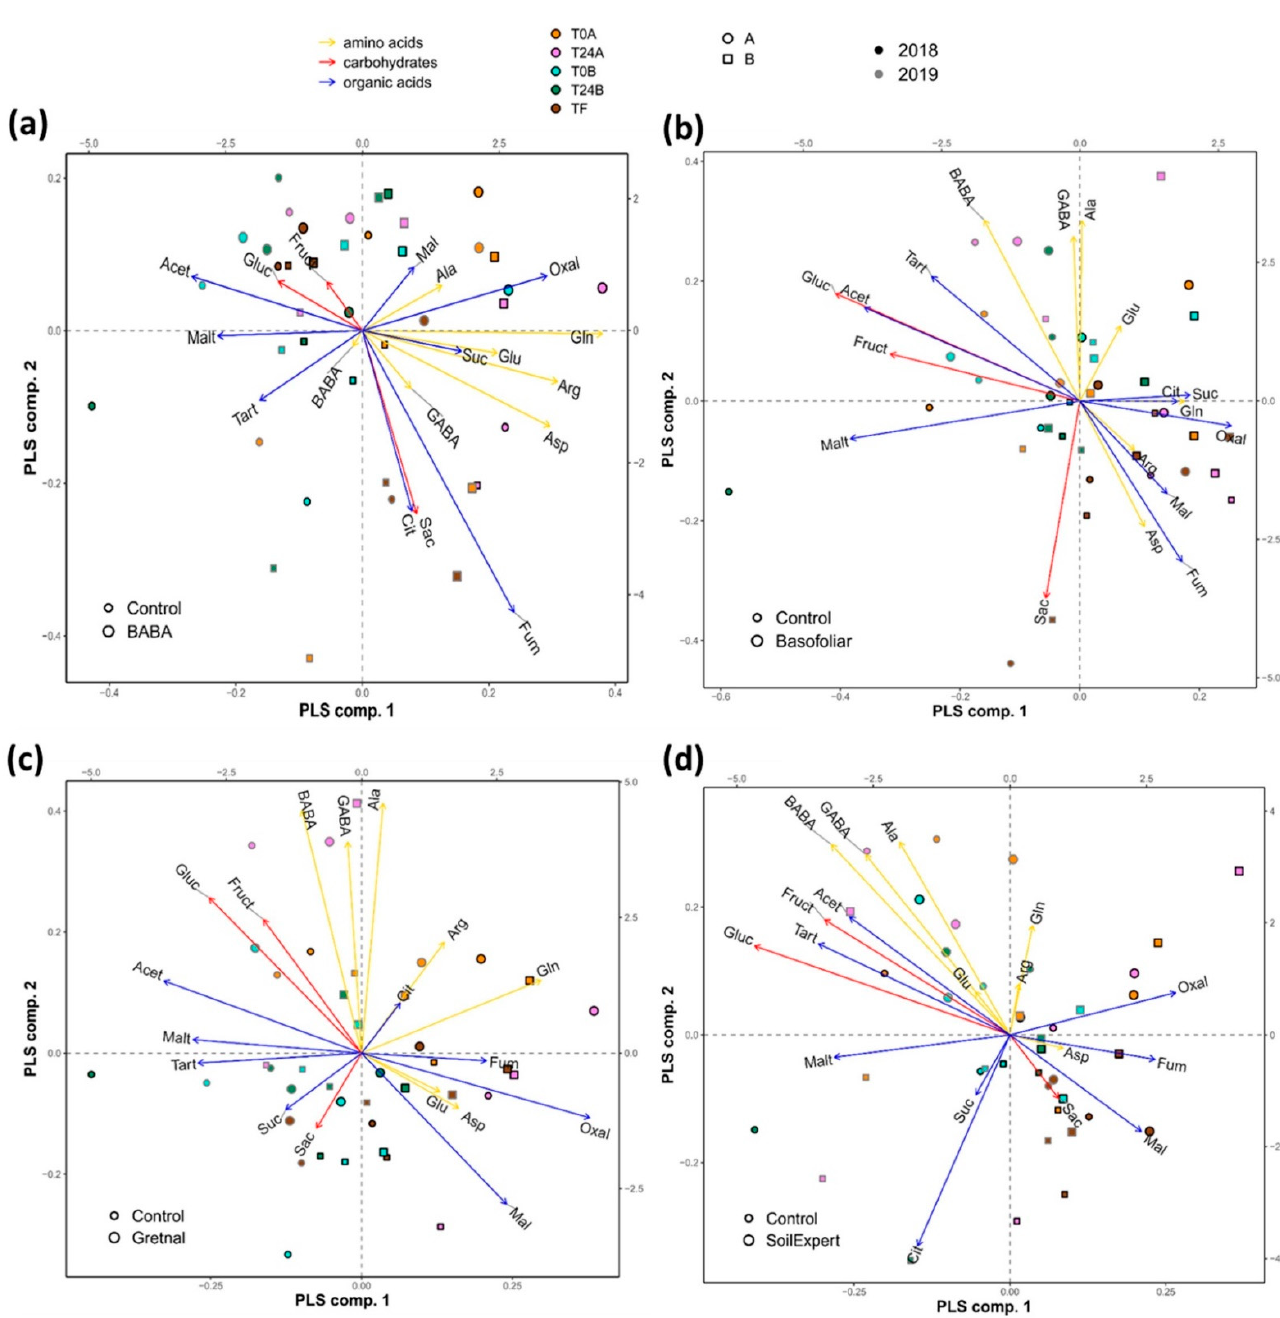
Figure 6. Partial least squares discrimination analysis (PLS-DA) in leaves of Vitis vinifera var. Tempranillo from two subplots (A and B) collected before and after the first (T0A and T24A, before flowering) and second (T0B and T24B, after flowering) foliar application and at maturity (TF) in the 2018 or 2019 season with ( a ) distilled water (control) vs. BABA; ( b ) distilled water (control) vs. Basofoliar (BF); ( c ) distilled water (control) vs. Greetnal (GT); ( d ) distilled water (control) vs. SoilExpert (ST). Free AAs: L-aspartic acid (Asp), L-glutamic acid (Glu), L-asparagine (Asn), L-glutamine (Gln), L-arginine (Arg), L-alanine (Ala), γ -aminobutyric acid (GABA), β -aminobutyric acid (BABA) and α -aminobutyric acid (AABA). Carbohydrates: D-(-)-fructose (Fruct), D-(+)-glucose (Gluc), sucrose (Sac), and maltose (Malt). AcOrg: oxalic acid (Oxal), L-(+)-tartaric acid (Tart), DL-malic acid (Mal), acetic acid (Acet), citric acid (Cit), succinic acid (Suc), and fumaric acid (Fum). In grapes and must, the differences between treatments were more evident, but the content of metabolites among both matrices also differed (Figure 7, Supplementary Table